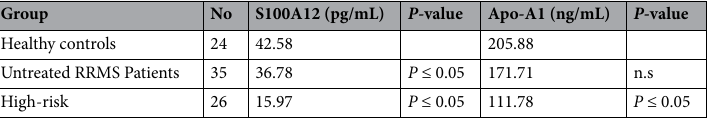
Group No S100A12 (pg/mL) P